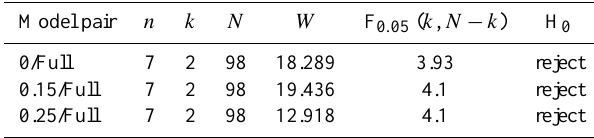
Table 3. Same definitions as Table 2 but with the Levene test statis- tic applied to a group of seven pixels, where the fully randomised model phase function was found to best fit spherical albedo dif- ferences using minimised RMSE values. The model pair tests are between all other scattering phase function models and the fully randomised scattering phase function